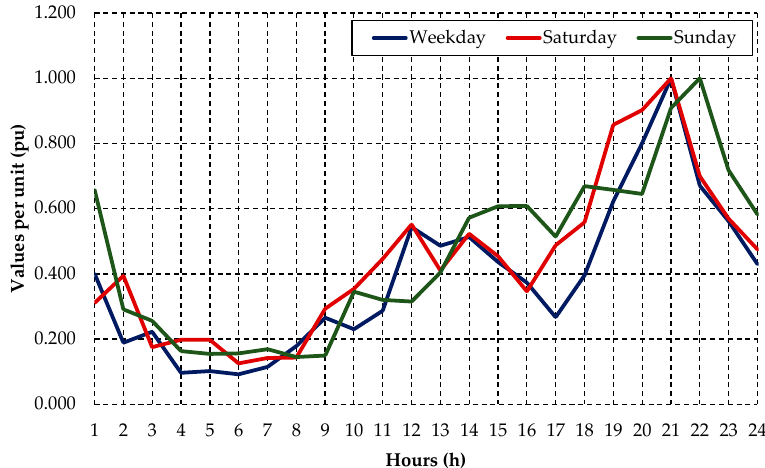
Figure 3. Typology of daily load profile for a residential customer. Source: The authors.